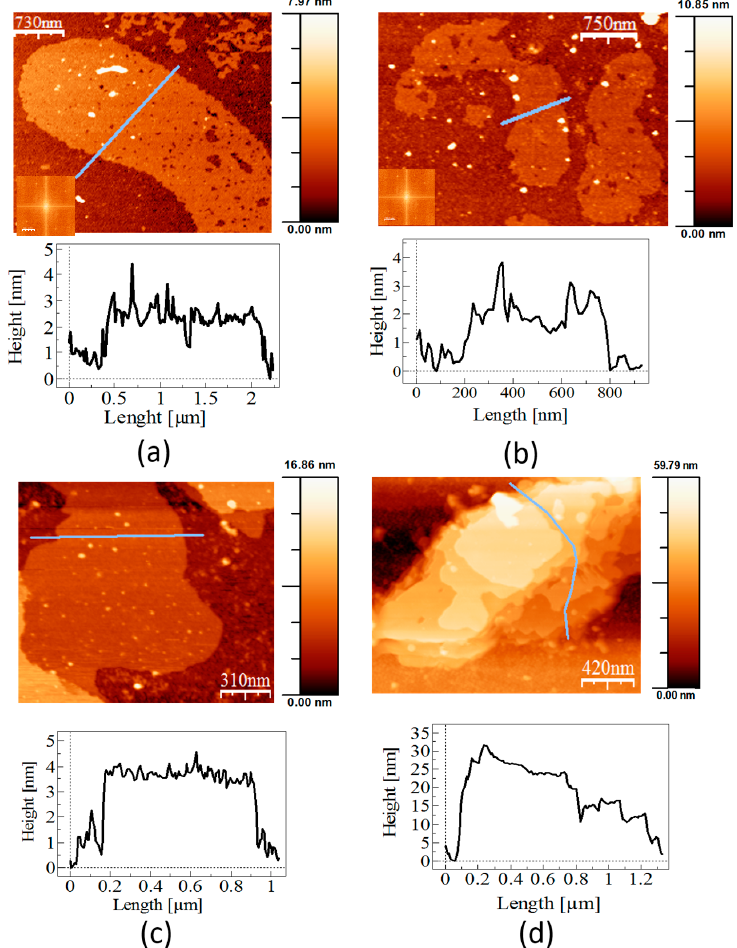
Figure 3. In vitro recrystallisation of recombinant SslA on a silicon wafer. AFM micrographs of the self-assembly products formed by the recombinant mature SslA and SslA truncation derivatives. ( a ) The recombinant mature SslA and ( b ) the CN-terminal truncation derivative after